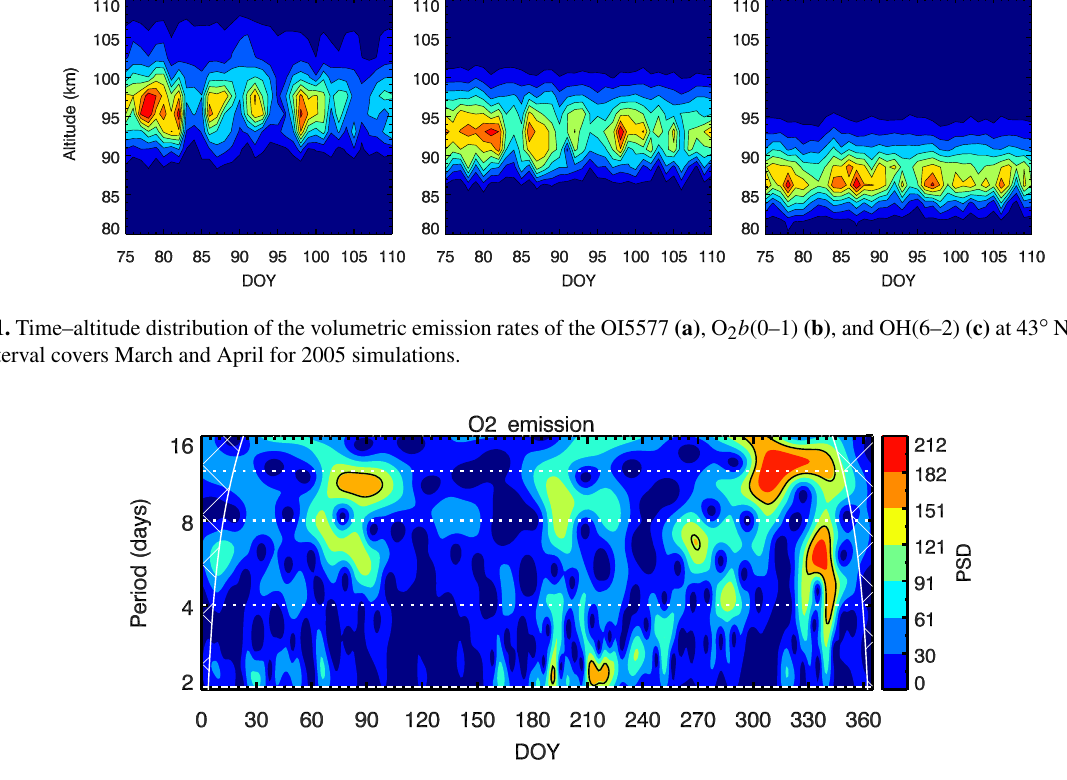
Figure 2. Wavelet spectrum of the nightly mean column intensity of the O 2 b (0–1) emission rates simulated by the Kyushu GCM at 43 ◦ N and 143 ◦ E from January to December